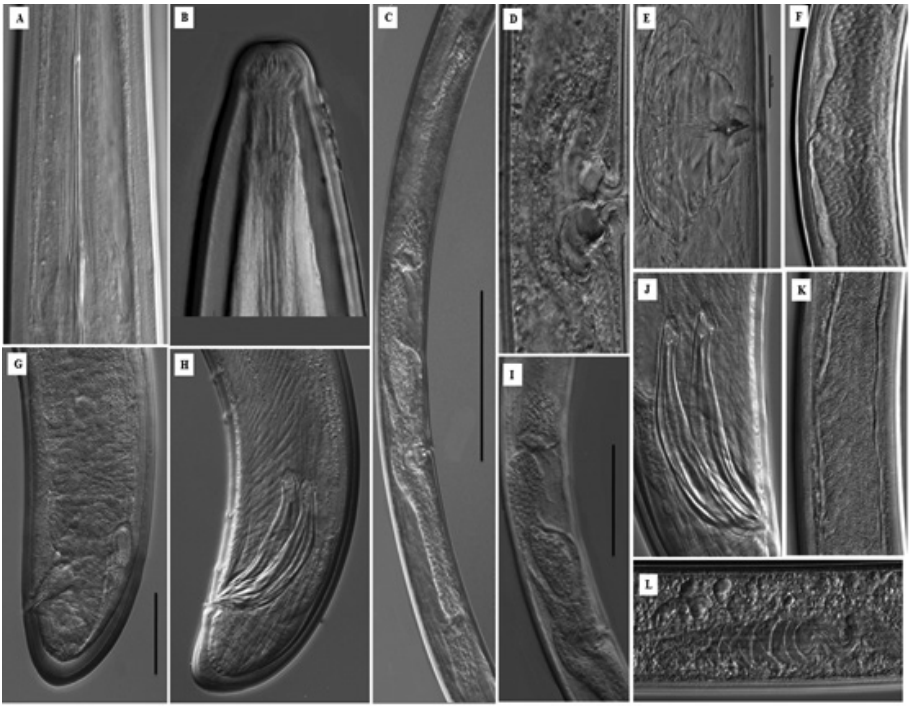
Figure 3. Longidorus cheni sp. n. Female : A Odontophore region B Amphidial fovea shape C Repro- ductive system D–E Vulval region F Sperms inside uteri I Oviduct separated by sphincter G Tail re- gion L Ovary. Male : H Tail end J Spicule K Testis with sperms. Scale bars: 20 μm ( A, B, E, G, H, J ); 100 μm ( C ); 50 μm ( D, F, I, K, L